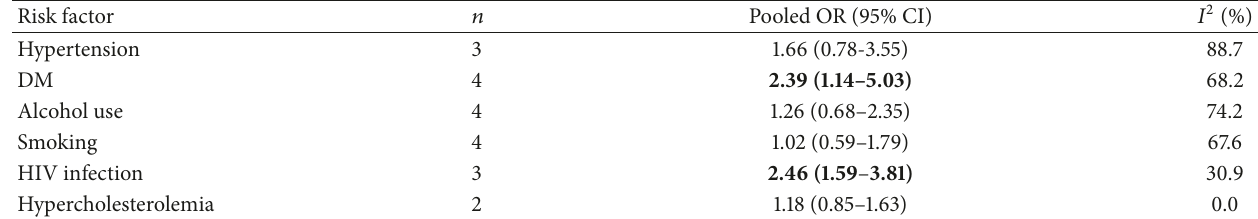
Table 3: Risk factors for all stroke expressed as odds ratios with 95% CI values.